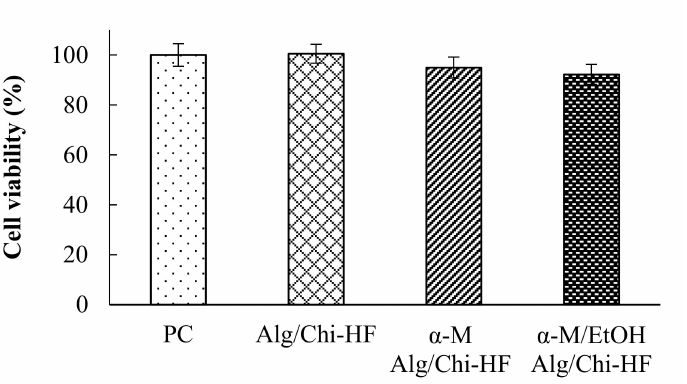
Figure 7. In vitro cell viability of α -M/EtOH Alg/Chi-HF. In vitro proliferation was carried out using NIH/3T3 cells. Each value represents the mean ± SD of three